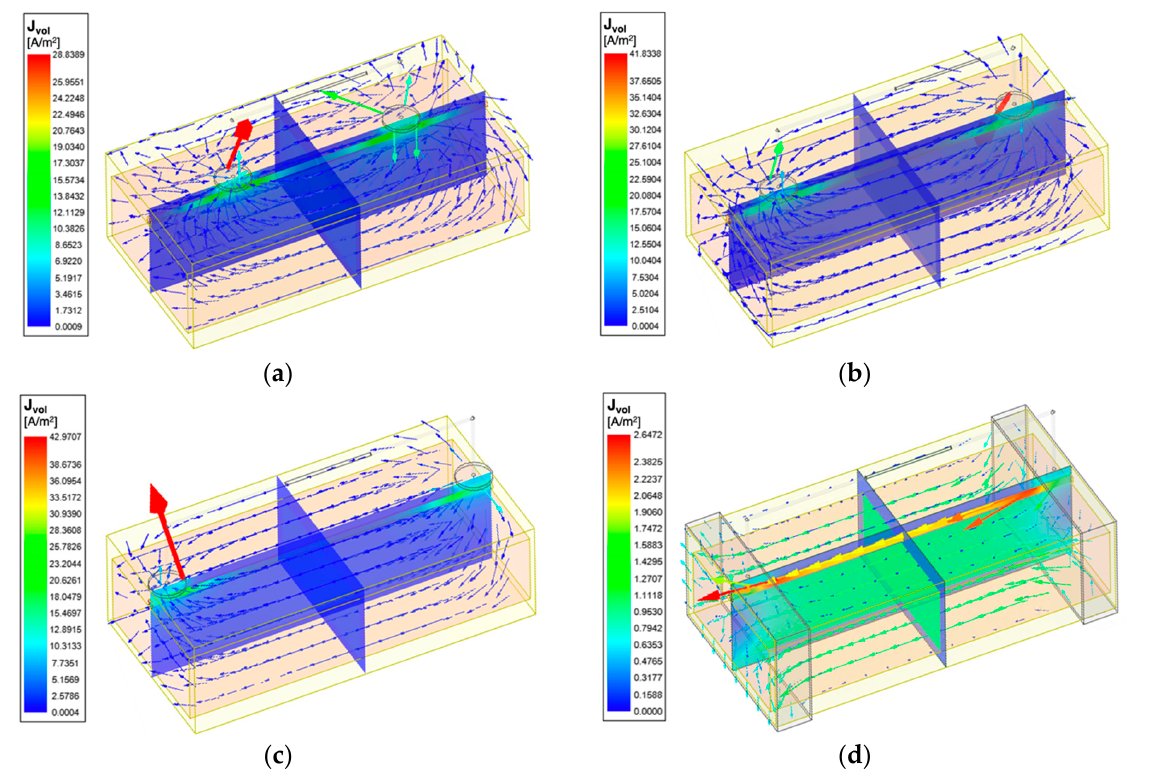
Figure 10. Current vectors and current density overlay of the wrist model 1 at 100 kHz: ( a ) 4-spot electrodes with L CC = 50 mm; ( b ) 4-spot electrodes with L CC = 70 mm; ( c ) 4-spot electrodes with L CC = 90 mm; ( d ) band electrodes with L CC = 90 mm.